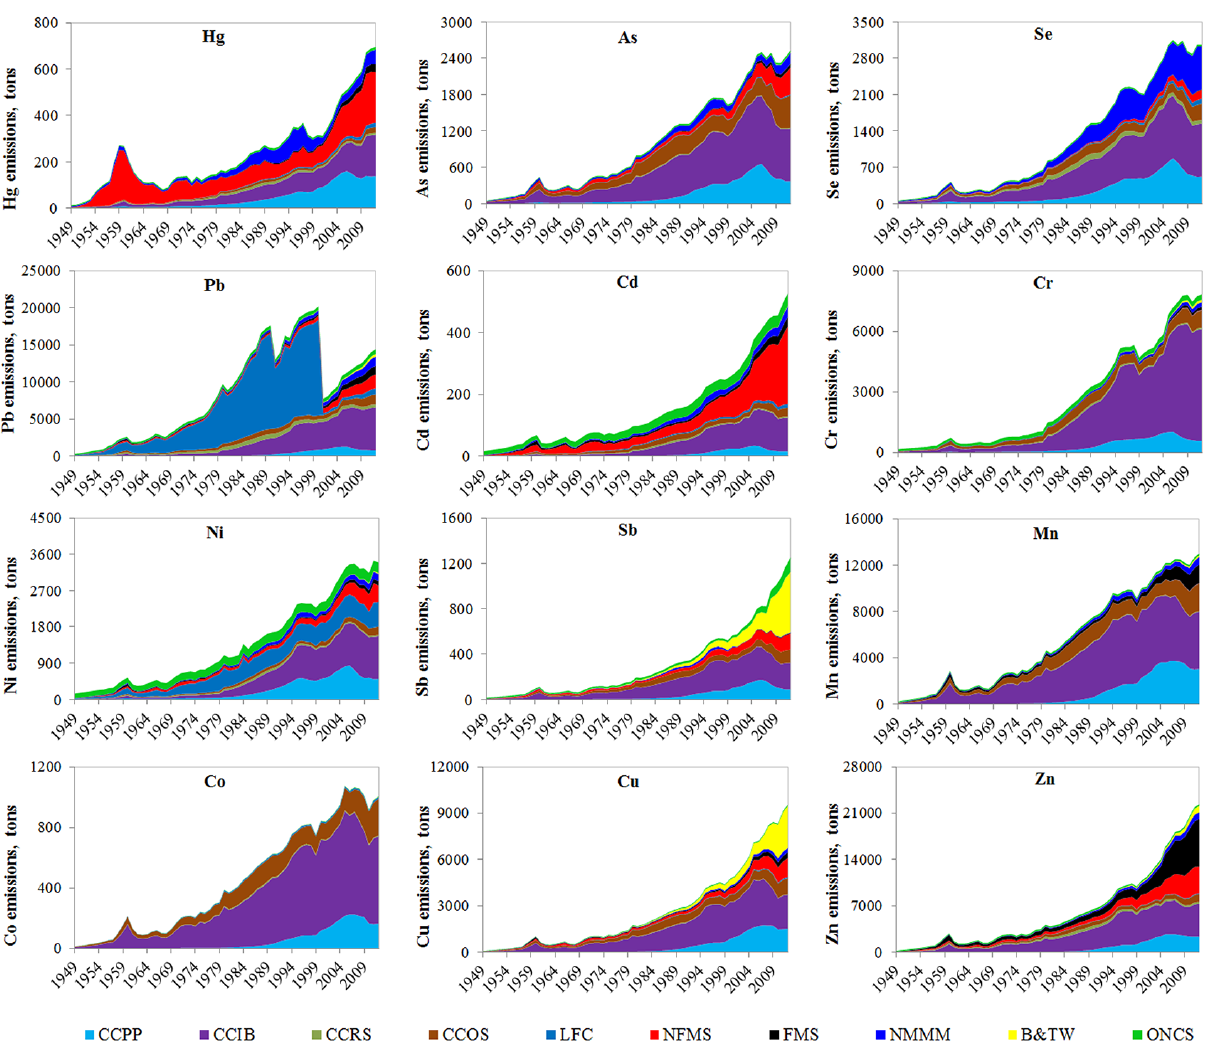
Figure 2. Historical trends of atmospheric HMs (Hg, As, Se, Pb, Cd, Cr, Ni, Sb, Mn, Co, Cu, and Zn) emissions from primary anthropogenic sources in China, 1949–2012. CCPP, coal consumption by power plants; CCIB, coal consumption by industrial boilers; CCRS, coal con- sumption by residential sectors; CCOS, coal consumption by other sectors; LFC, liquid fuels combustion; NFMS, nonferrous metal smelting; FMS, ferrous metal smelting; NMMM, non-metallic minerals manufacturing; B&TW, brake and tyre wear; ONCS, other non-coal sources (including BB, biomass burning; and MSWI, municipal solid waste